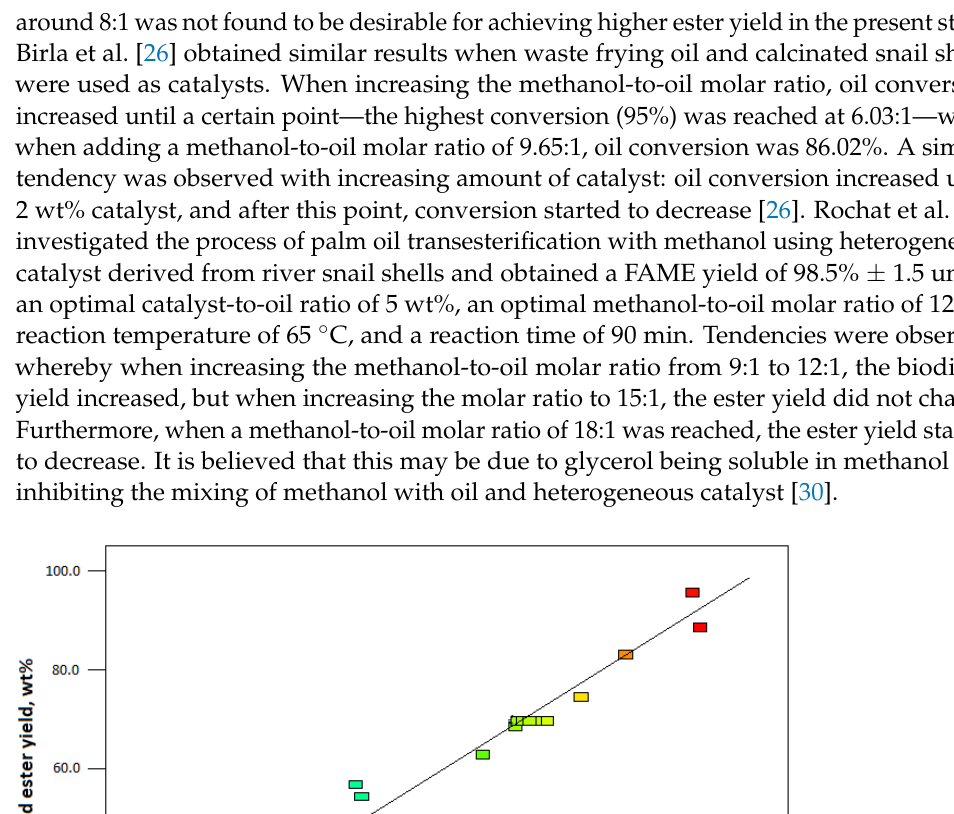
Table 3. Statistical parameters determined using ANOVA.